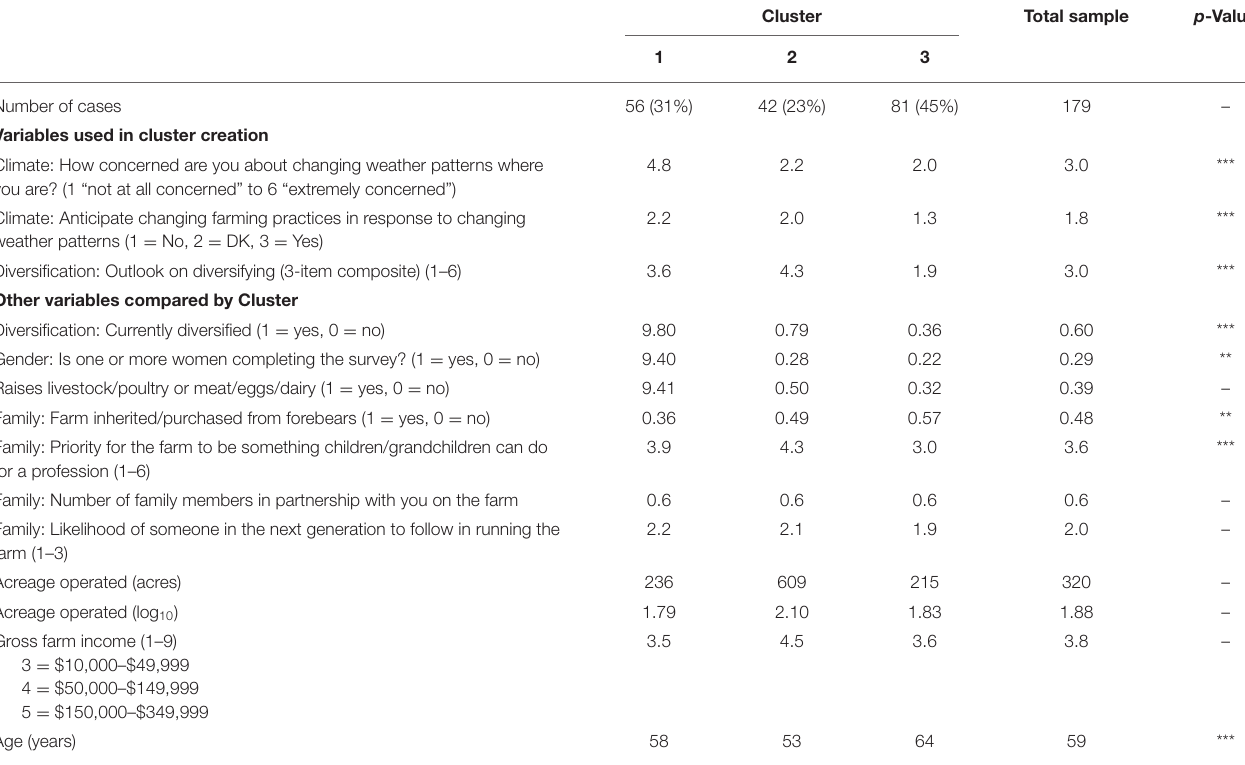
TABLE 7 | Research question 3: Outlooks on diversifying: Results of cluster analysis to characterize respondents’ perspectives on climate change and farm product diversification: Mean values for variables used in cluster creation and for other variables compared by cluster. Cluster Total sample